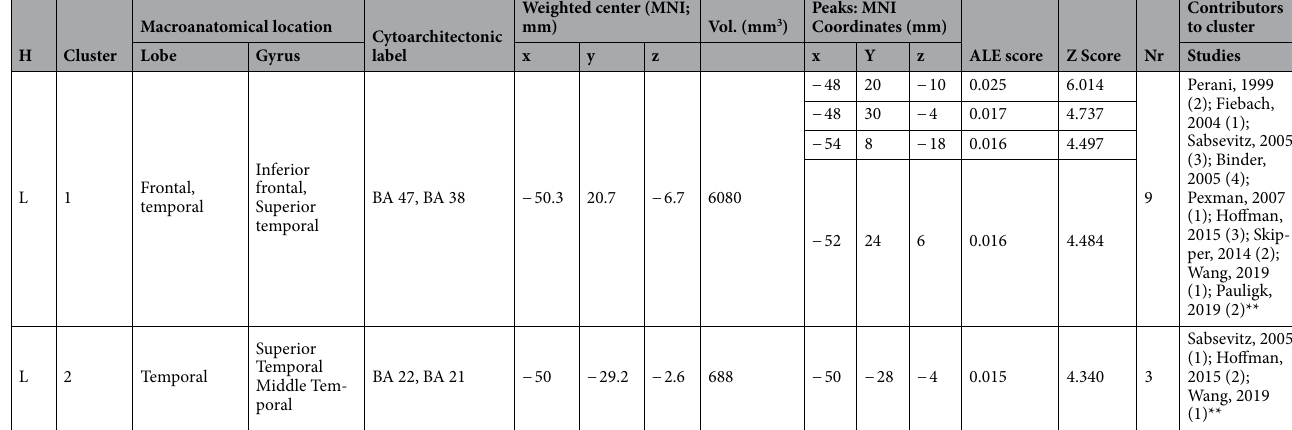
Table 9. Abstract > concrete words—semantic and lexical task only- clusters. Included 116 stereotactic activation loci from 17 studies, 289 participants, Chosen min. cluster size 680 mm 3 . All the values and labels were extracted from the GingerALE output files. Clusters are ordered for decreasing volume size. Coordinates (x, y, z) are in the MNI space. H = Hemisphere; ALE = activation likelihood estimation; Nr. = number of studies that contributed to each cluster; L = left; BA = Brodmann area; ** = between brackets are the number of foci from each study that contributed to that specific